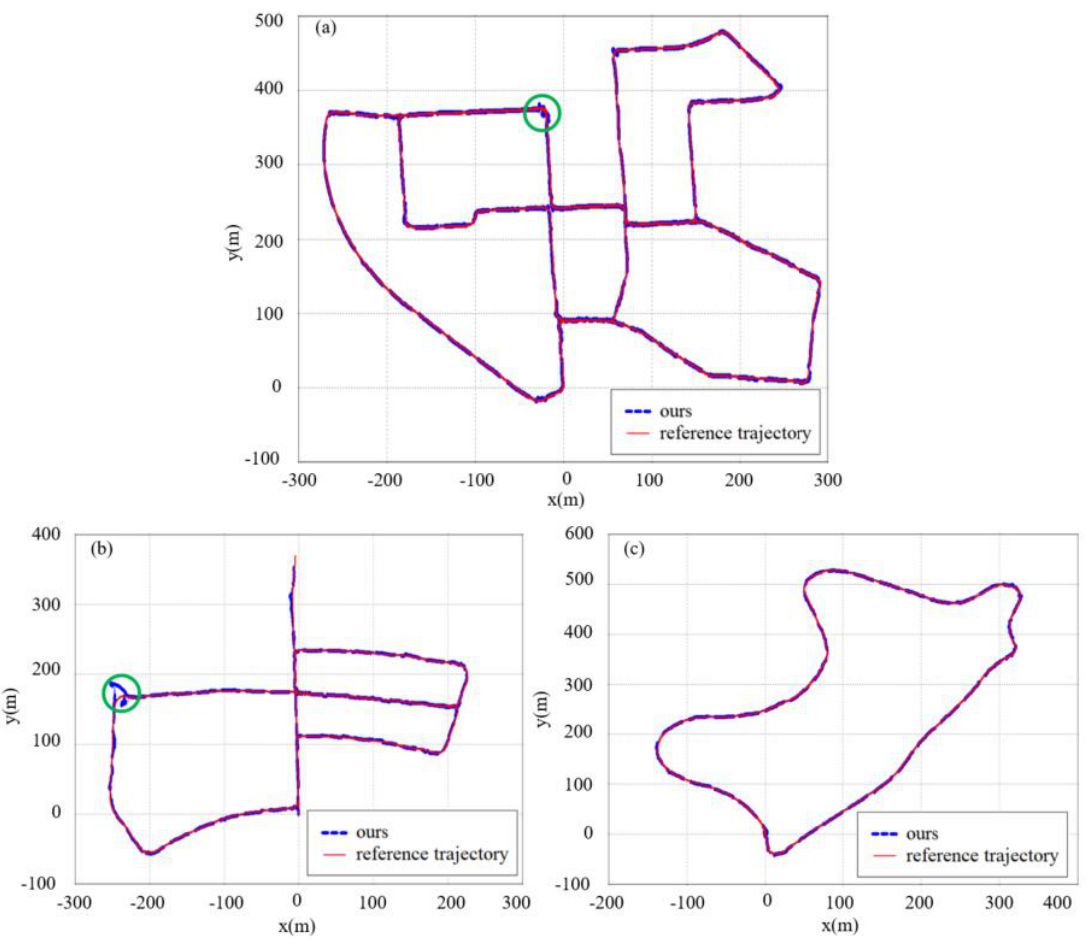
Figure 6. Comparison of localization results between the proposed method and the reference trajectories. ( a ) Sequence 00 of the KITTI dataset; ( b ) sequence 05 of KITTI dataset; ( c ) sequence 09 of KITTI dataset.